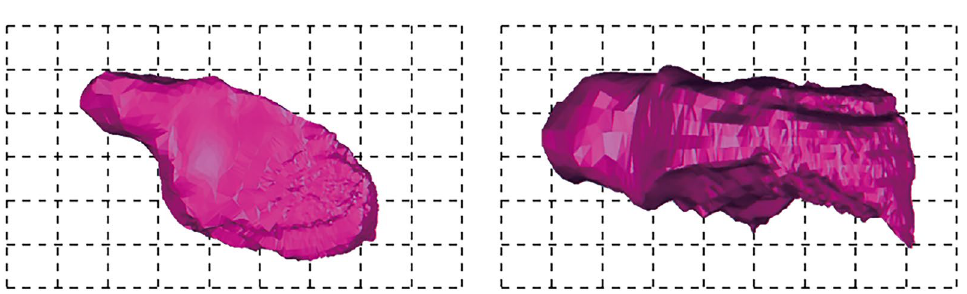
Figure 15. 1290 Flat plate 1290-302 Drilling 3D laser scanning 3D model. The roof of the goaf is relatively regular and flush, the thickness of the roof is basically the same.